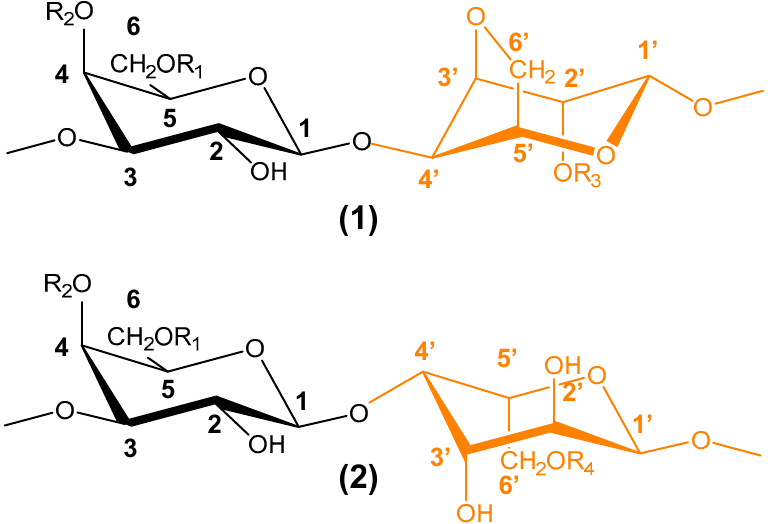
Figure 5. Schematic structures of the agarobiose disaccharides present in agar, (1) 3,6-anhydro- α - L - galactopyranosyl containing agarobiose; (2) L -galactose containing agarobiose. R 1 = H, CH 3 or SO 3 − ; R 2 = H, CH 3 or SO 3 − ; or R 1 and R 2 = C(CH 3 )CO 2 H; R 3 = H or CH 3 ; R 4 = H or SO 3 − .